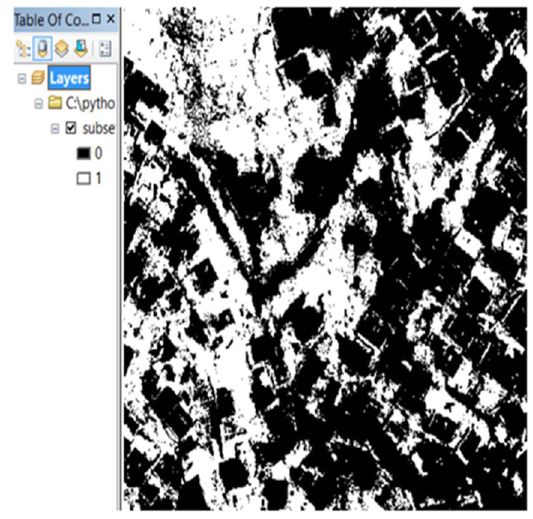
Figure 11: Shadow free vegetation